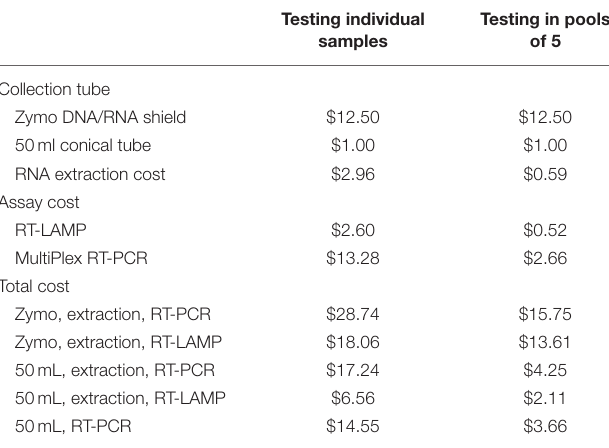
TABLE 3 | Cost per sample comparison across different collection and processing methods.